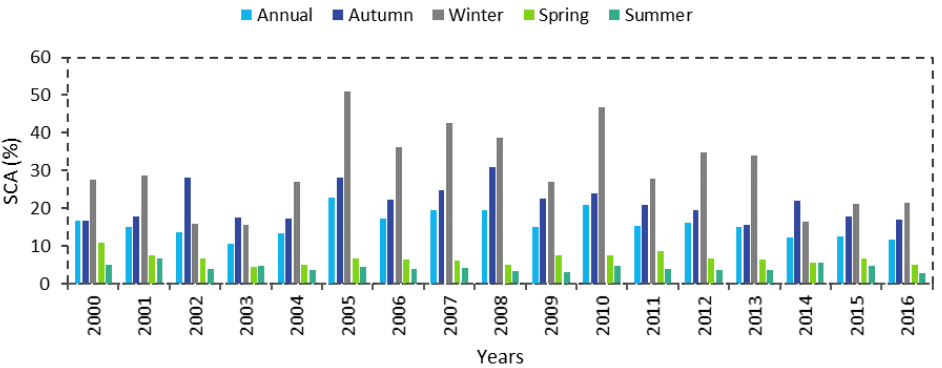
Figure 5. Annual and seasonal mean SCA (%) for the 2000–2016 period.